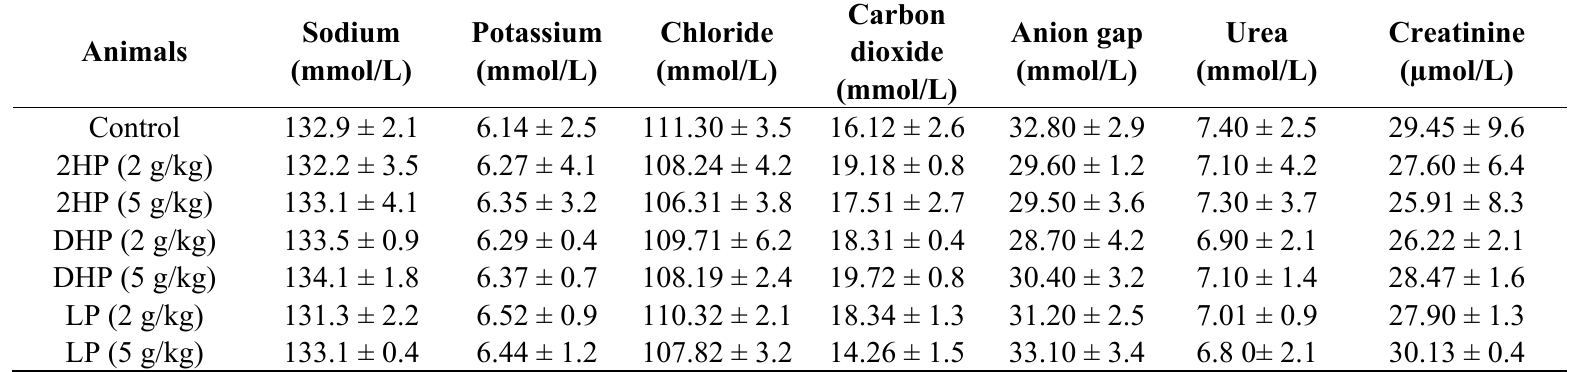
Table 2. Renal function test of rats used in acute toxicity assessments of 1-(2-ketoiminoethyl)piperazine Schiff bases.